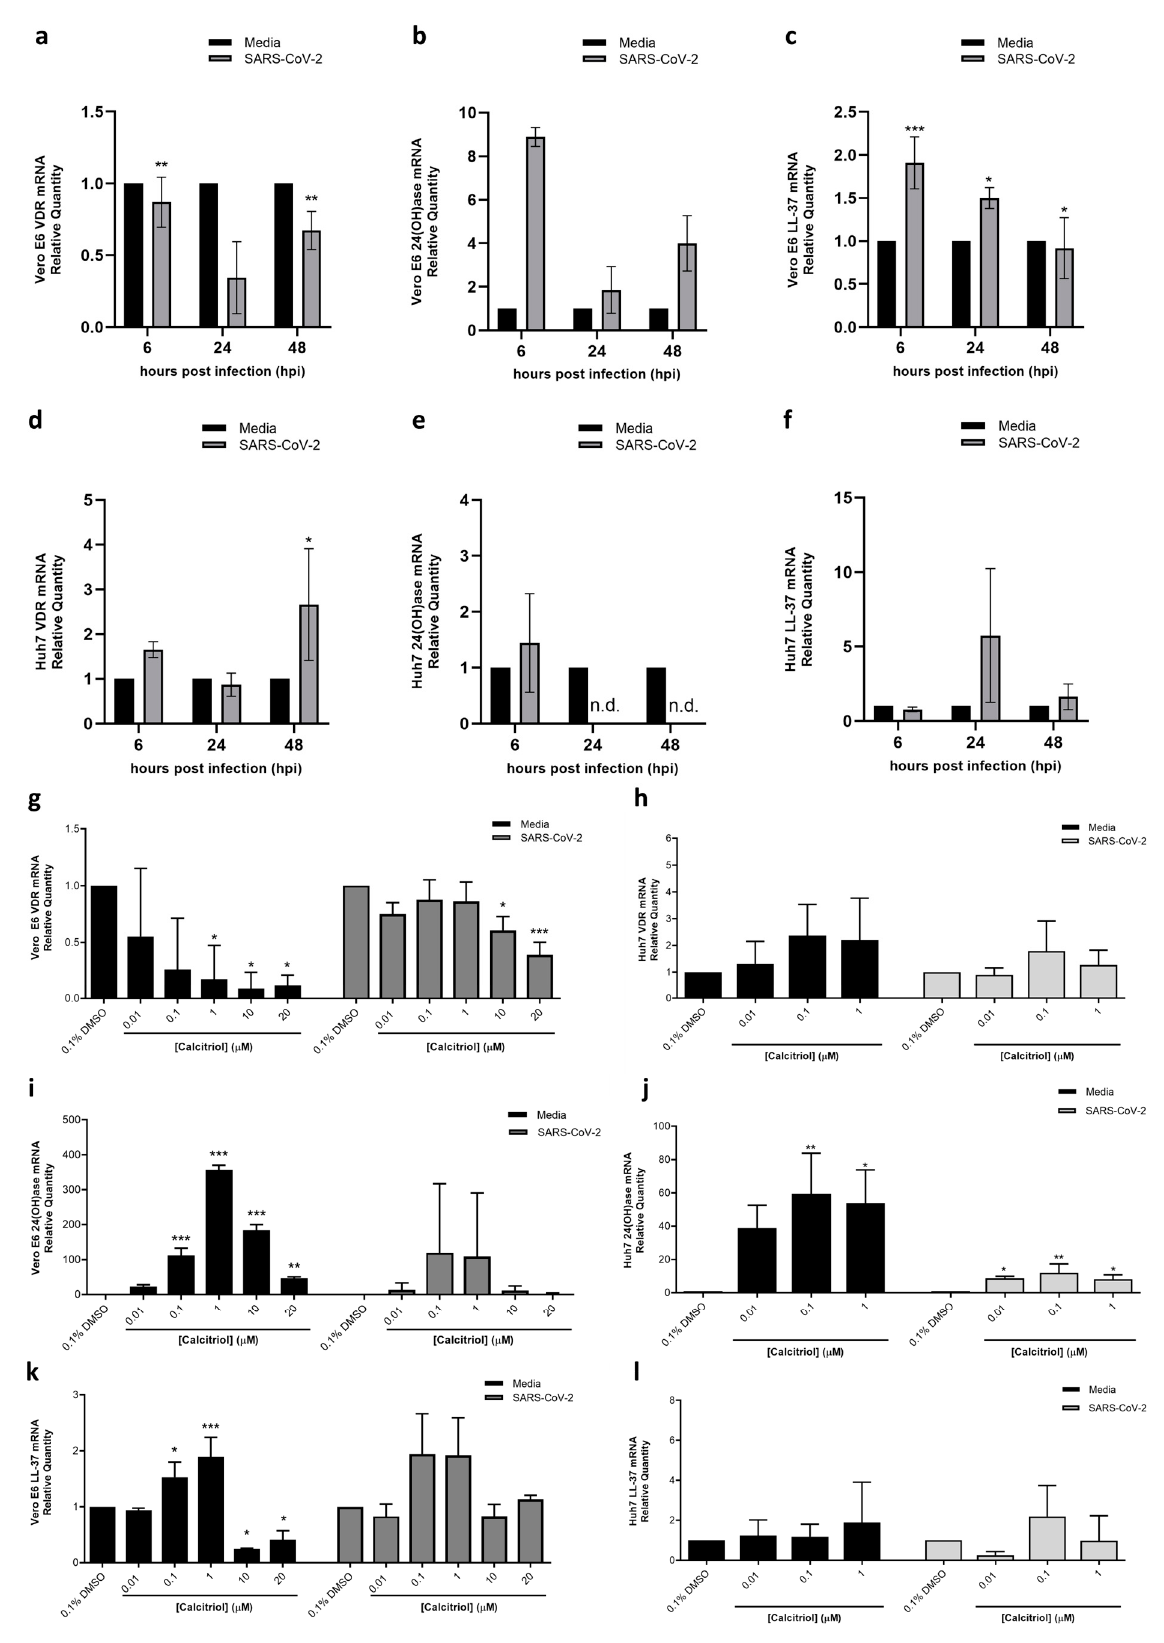
Figure 4. SARS-CoV-2 and calcitriol modulate vitamin D Receptor (VDR), 24-hydroxylase (24(OH)ase), and cathelicidin (LL-37) in Vero E6 and Huh7 cells. In the first part of the experiment, Vero E6